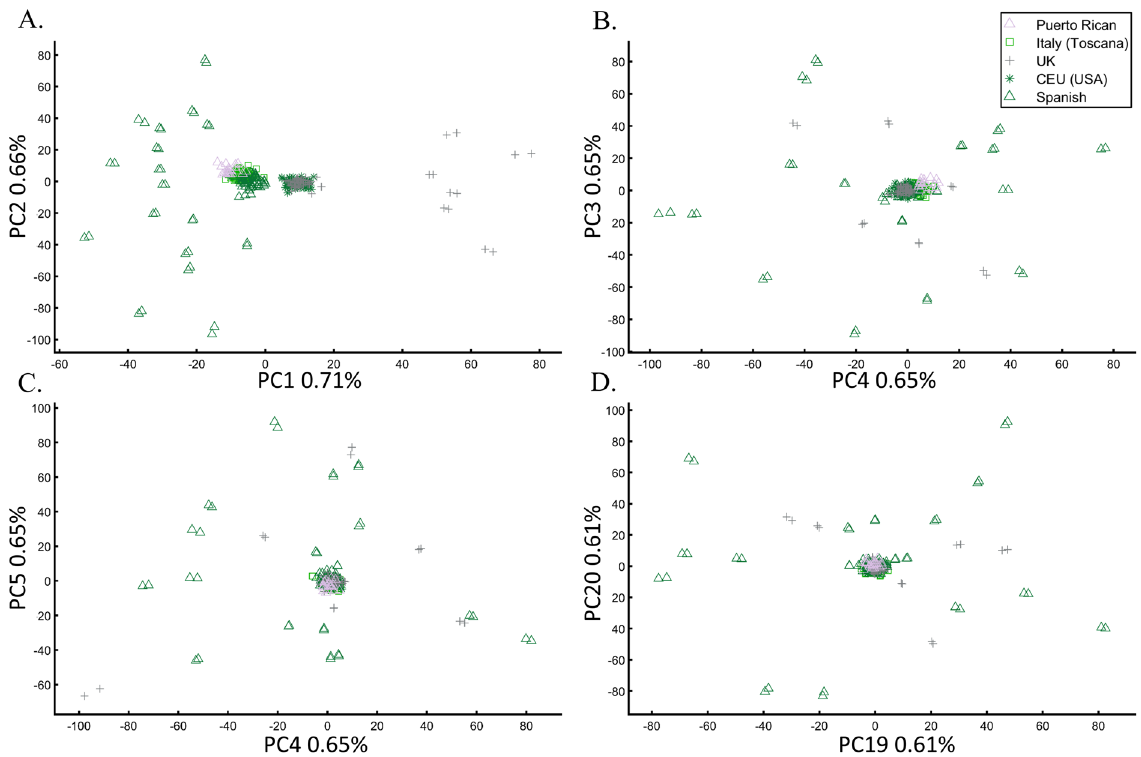
Figure 15. PCA of 20 Puerto Ricans and 300 random Europeans from the 1000 Genomes. The results are shown for various